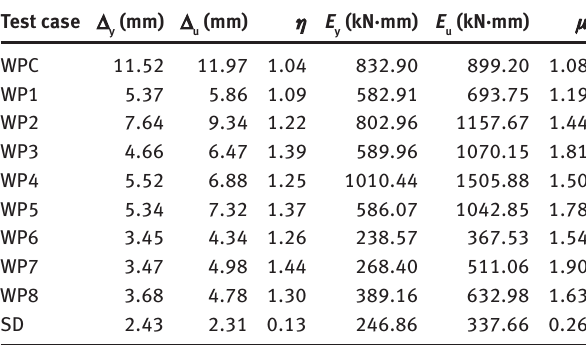
Table 4: Test results of specimens. Test case Δ